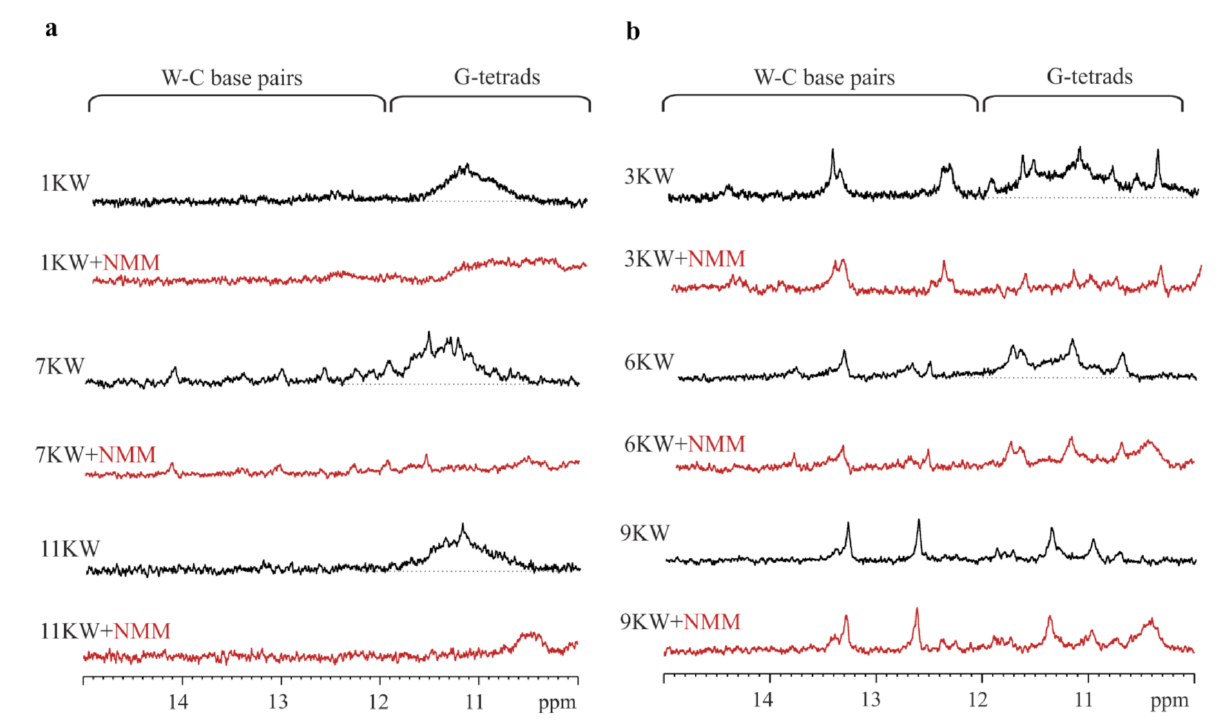
Figure 1. The imino region of the nuclear magnetic resonance ( 1 H NMR) spectra of PQS oligomers. ( a ) 1 H NMR spectra for 1KW, 7KW and 11KW variants (first group), ( b ) 1 H NMR spectra for 3KW, 6KW and 9KW variants (second